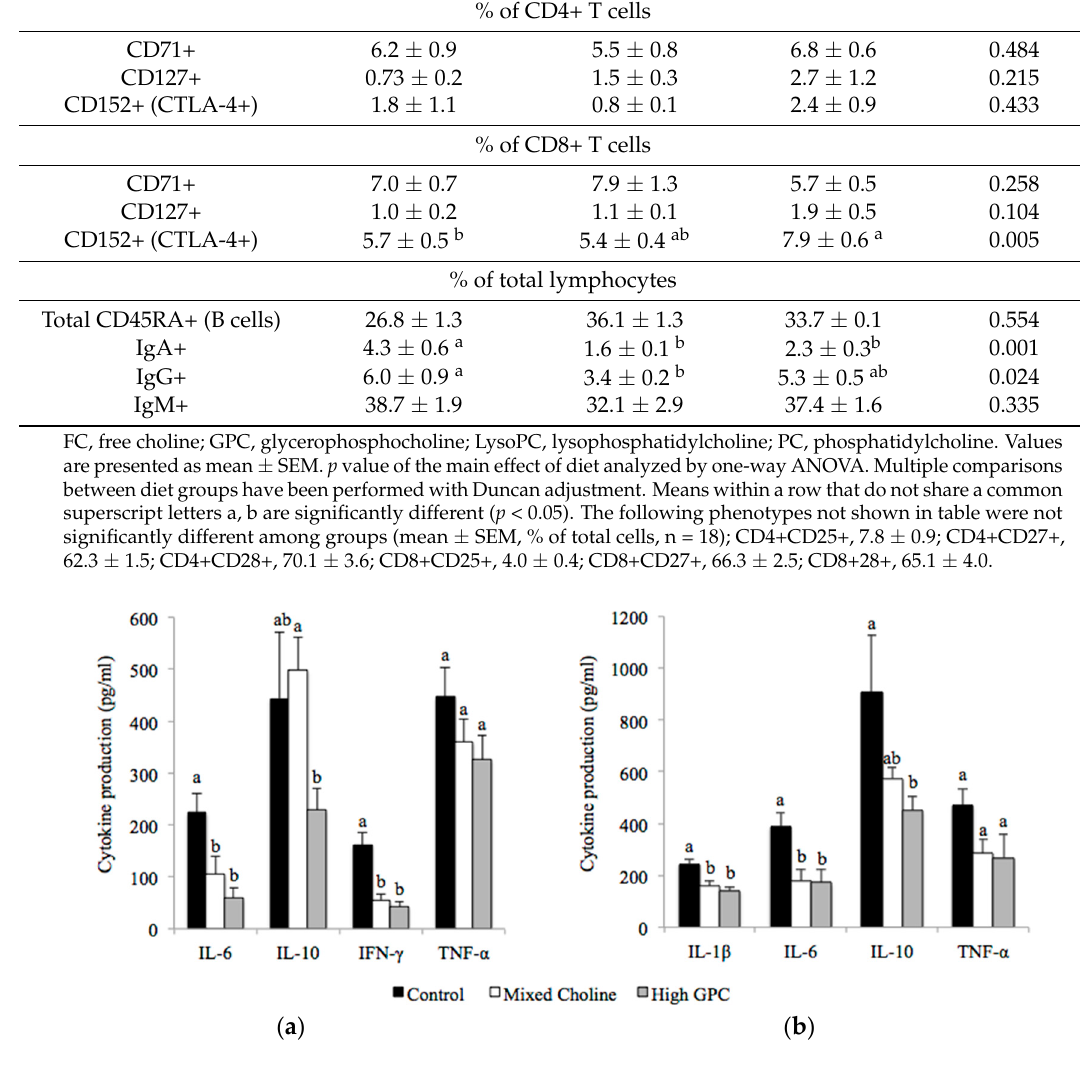
Figure 1. Cytokine production by splenocytes after ex vivo stimulation with Concanavalin A (ConA) ( a ) or lipopolysaccharide (LPS); ( b ) from lactating dams fed Control (100% FC) ( n = 6), Mixed Choline (MC; 50% PC, 25% FC, 25% GPC) ( n = 6) or High GPC (HGPC; 75% GPC, 12.5% PC, 12.5% FC) ( n = 6) diets. FC, free choline; GPC, glycerophosphocholine; PC, phosphatidylcholine. Values are presented as mean ± SEM. P value of the main effect of diet analyzed by one-way ANOVA. Multiple comparisons between diet groups have been performed with Duncan adjustment. Means within a row that do not share a common superscript letters a, b are significantly different ( P < 0.05).